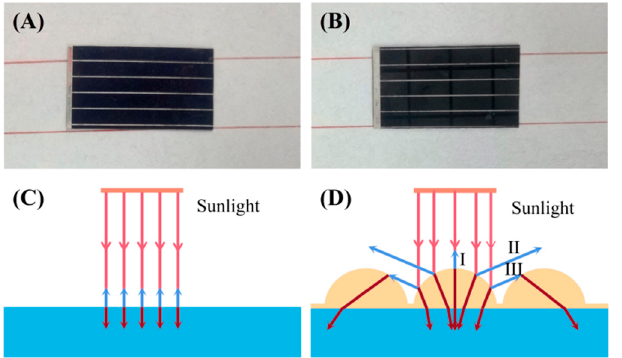
Figure 8. Photographs of silicon solar cells ( A ) without MLAs and ( B ) with MLAs and the transmission mechanism of light on ( C ) a bare silicon solar cell device and ( D ) a silicon solar cell device with hybrid film MLAs.